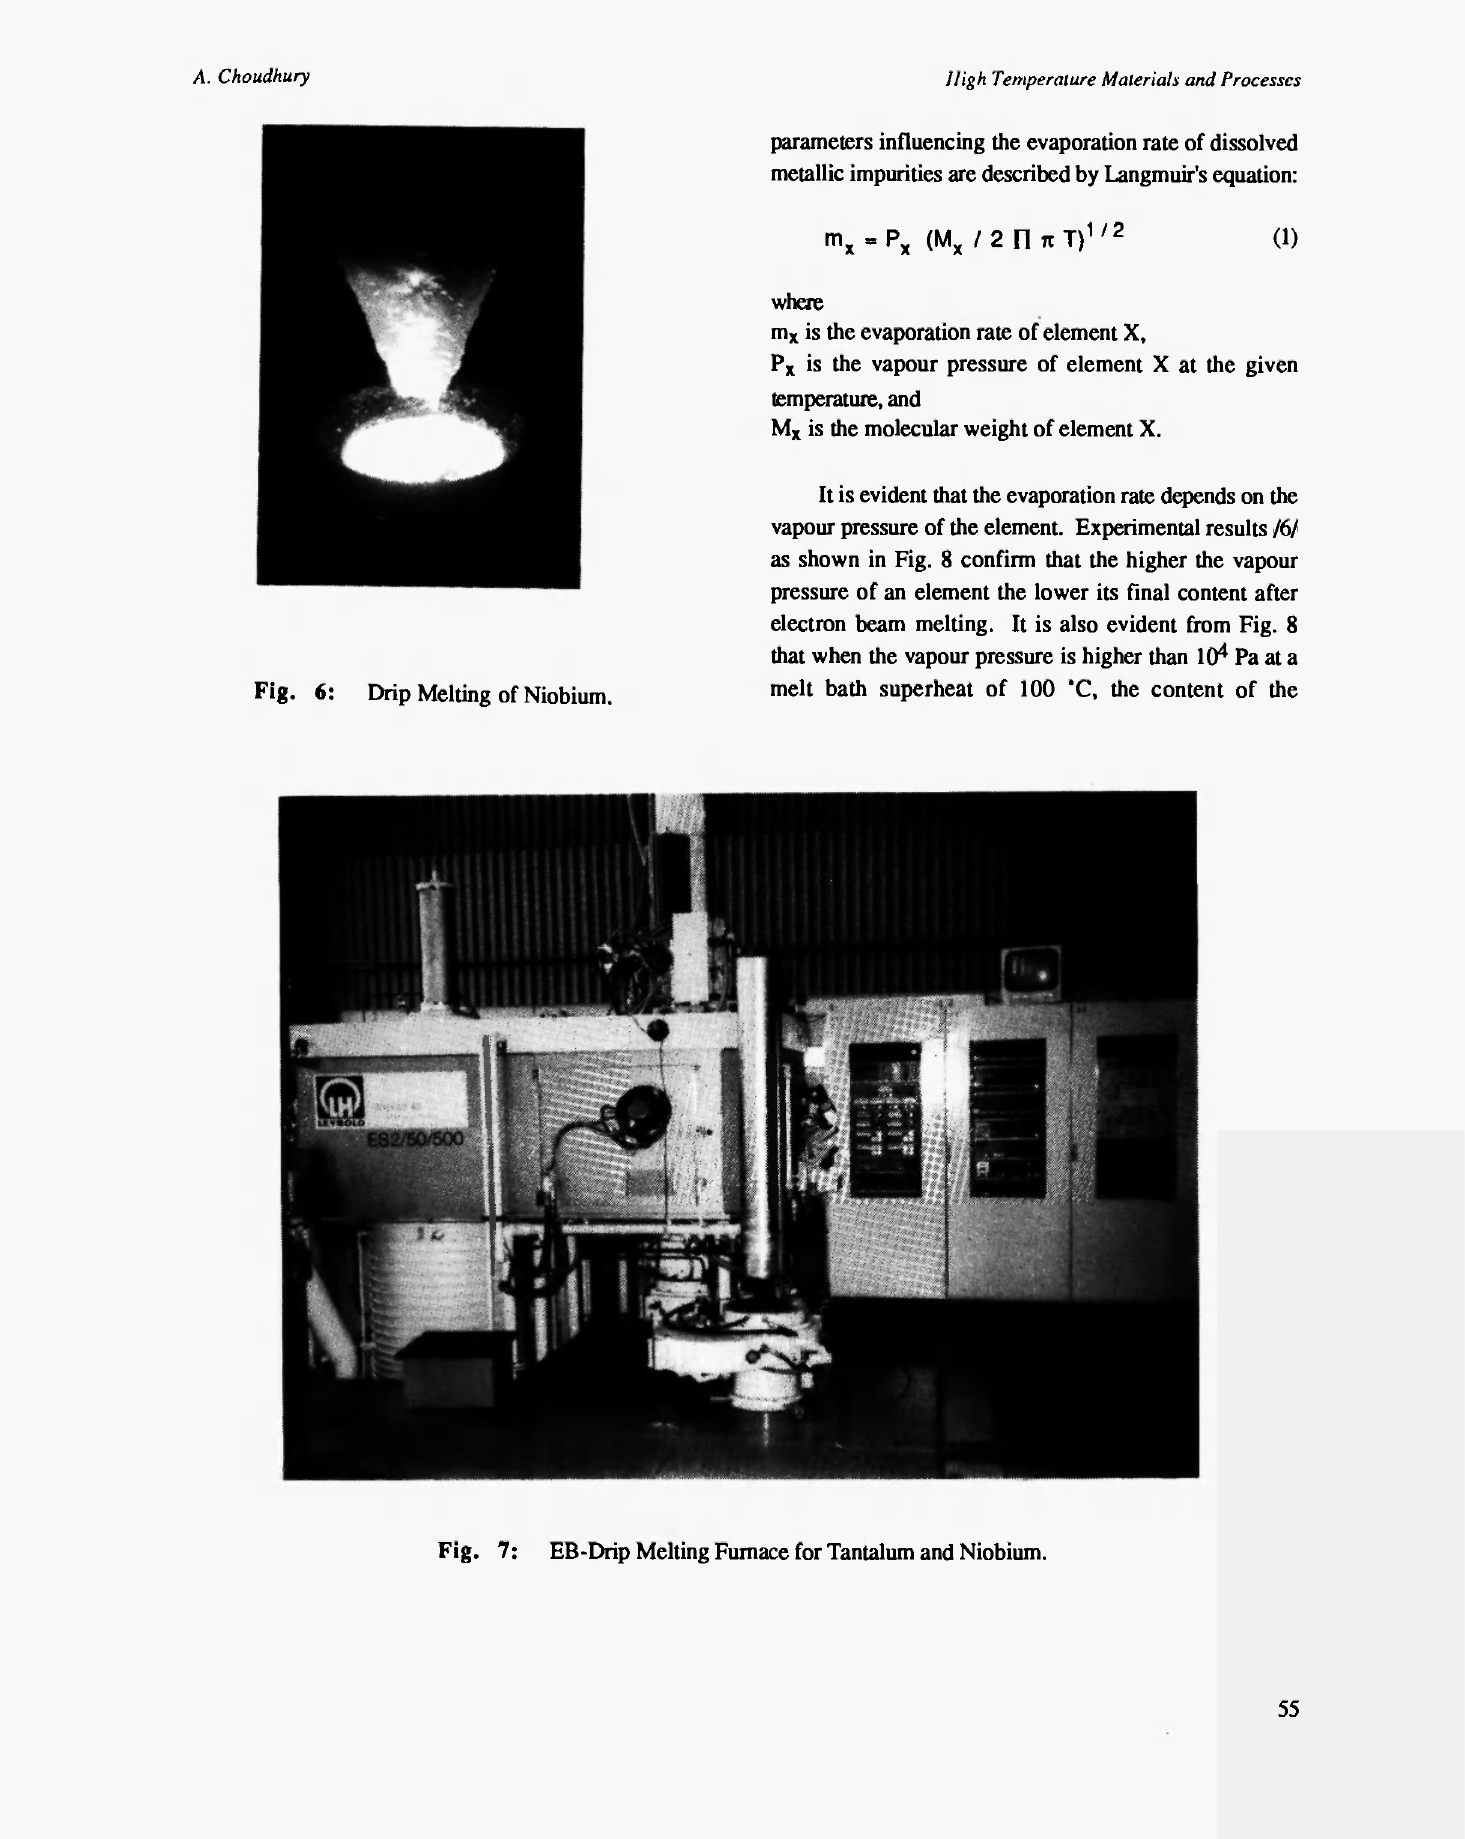
Fig. 6: Drip Melting of Niobium.